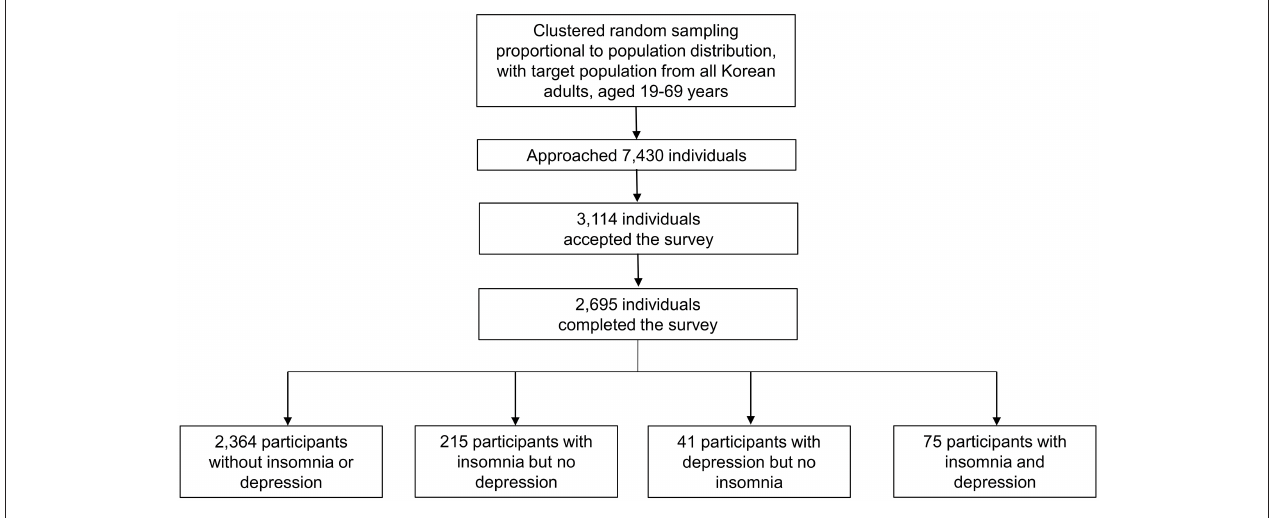
FIGURE 1 | Flow chart depicting the participation of individuals in the Korean Headache-Sleep Study.